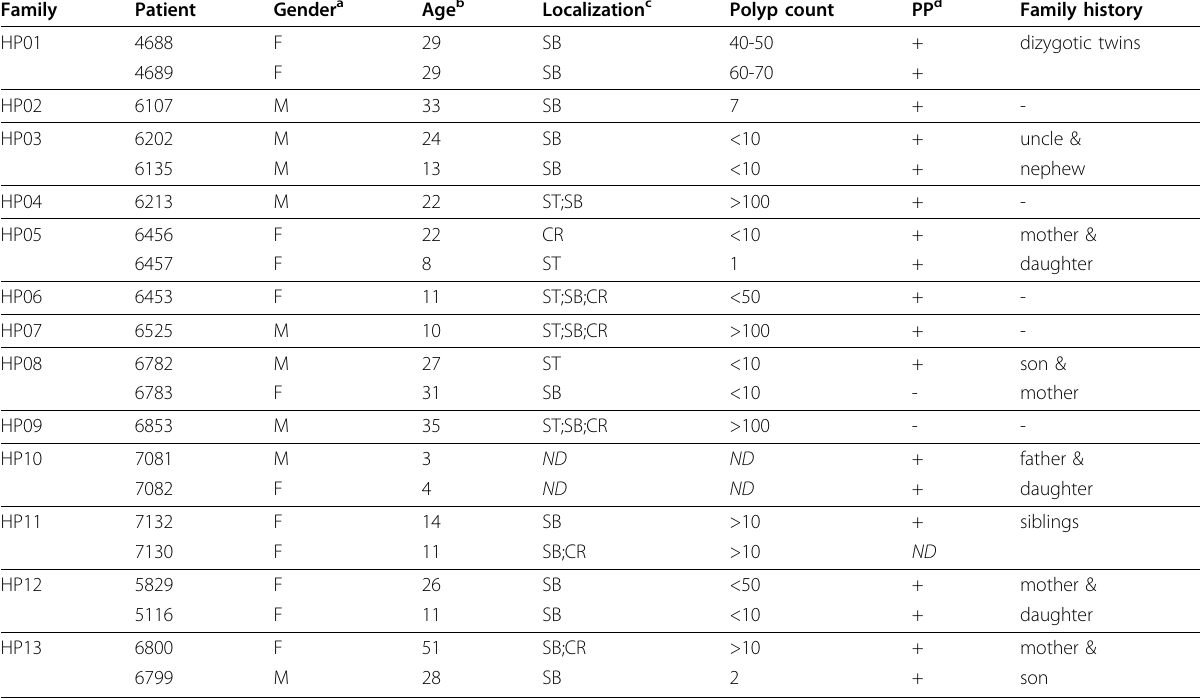
Table 1 Clinical characteristics of patients diagnosed with Peutz-Jeghers syndrome